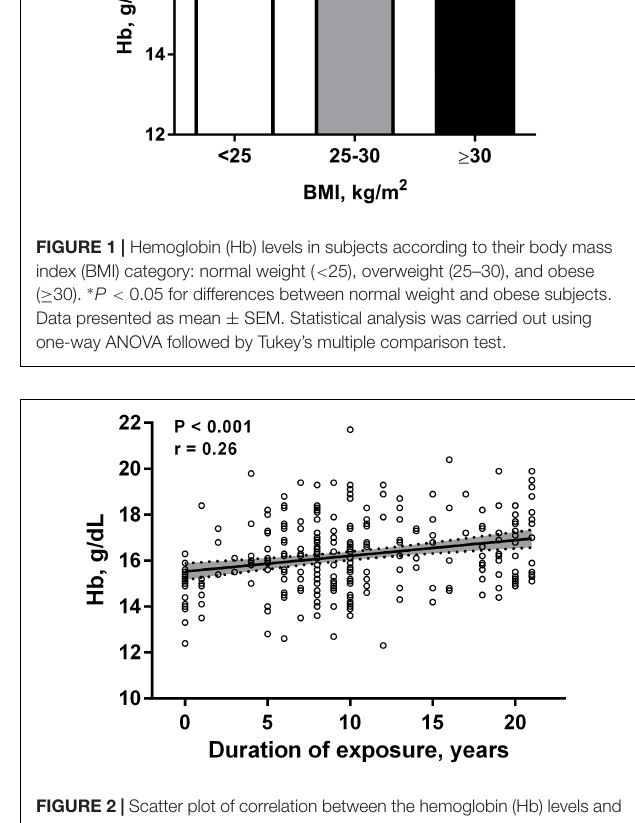
FIGURE 2 | Scatter plot of correlation between the hemoglobin (Hb) levels and the years of exposure to intermittent high altitude. The best-fit line is shown, and the shaded area represents the 95% confidence intervals ( n =